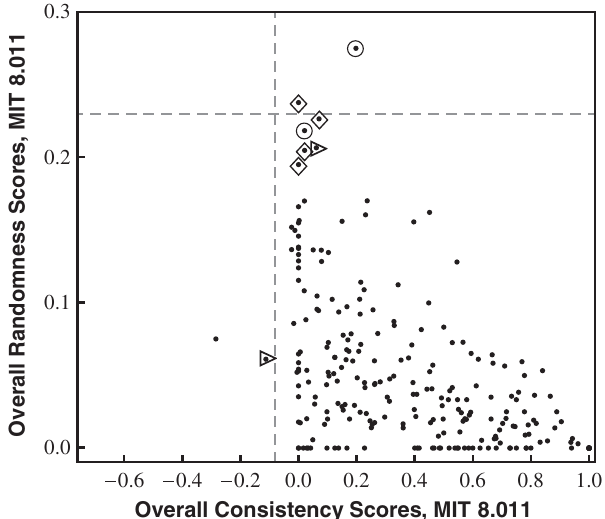
FIG. 5. Overall randomness [ R defined in Eq. (6)] vs over- total defined in Eq. (3)] for the 257 statements in all consistency [ C total the MIT 8.011 subsample. The dashed lines indicate the strong randomness cut of 0.23 and the strong (incorrect) consistency cut of (cid:1) 0 : 08 discussed in Sec. III. Points outlined with symbols are discussed in Sec. V.